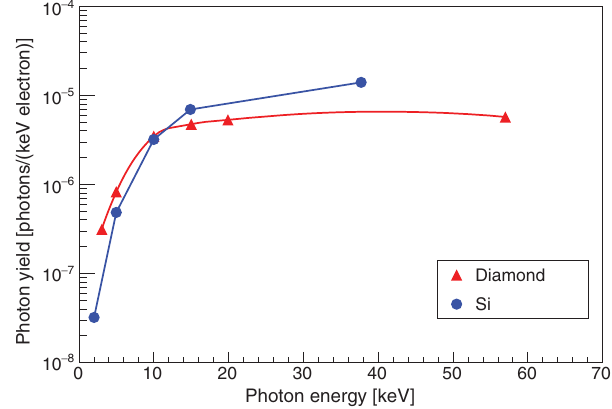
FIG. 8. Scattering angle estimated from fitting a Gaussian function depending on crystal thickness of Si and diamond. The beam tail is ignored.